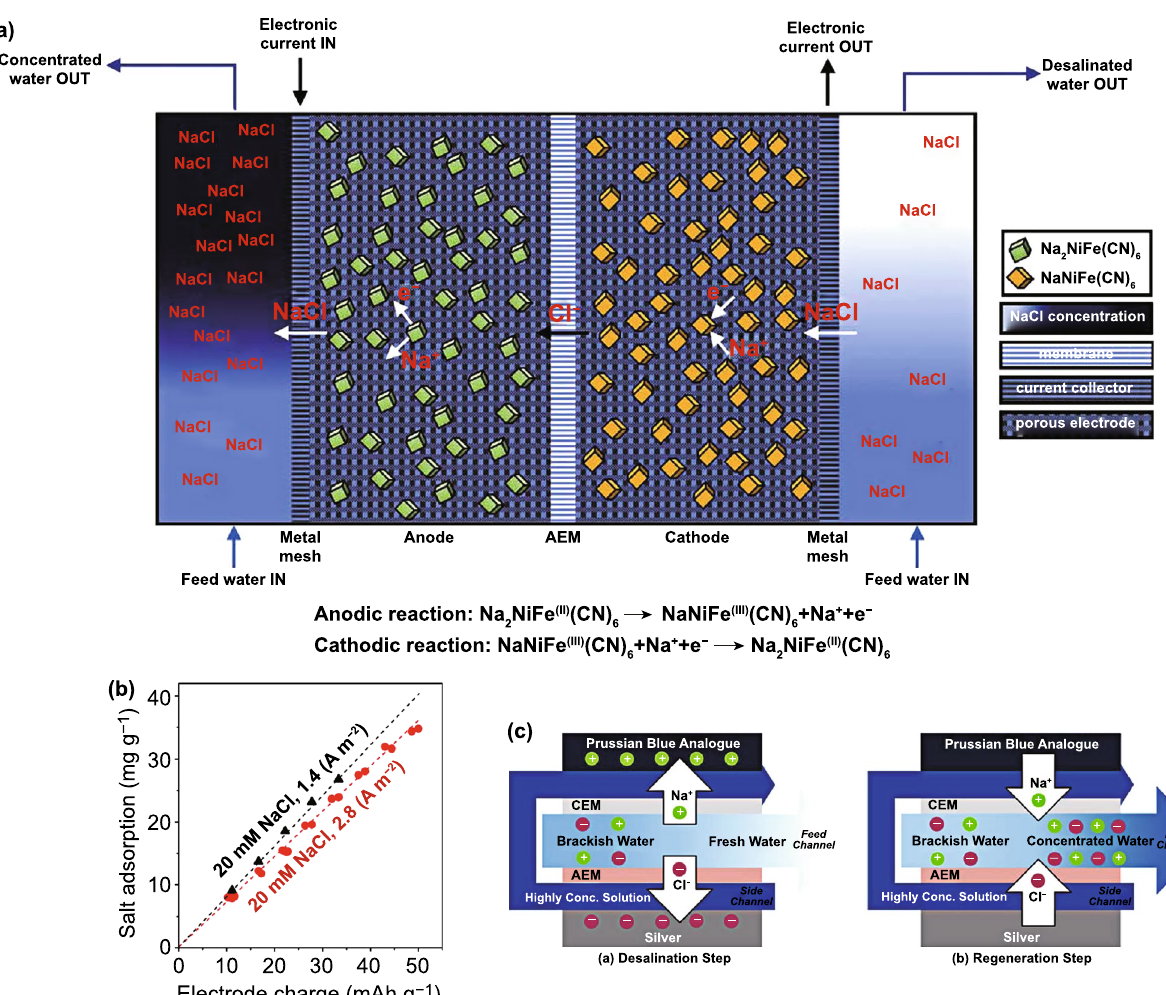
Fig. 15 a Schematic of NaNiFe(CN) 6 /Na 2 NiFe(CN) 6 desalination battery operation during discharge (desalination) and charge (salination). b Salt adsorption capacity of NaNiFe(CN) 6 . Reproduced with permission from Ref. [158]. Copyright 2017, Elsevier. c Schematic of multi-channel NaNiFe(CN) 6 /Ag desalination battery operation during discharge (desalination) and charge (salination). Reproduced with permission from Ref. [161]. Copyright 2019, American Chemical